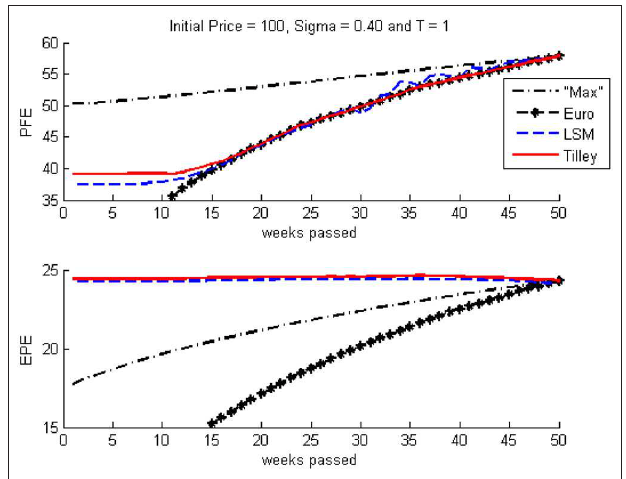
FIGURE 2 | EPE and PFE for an American Call Option simulated using Tilley Bundling and LSM.